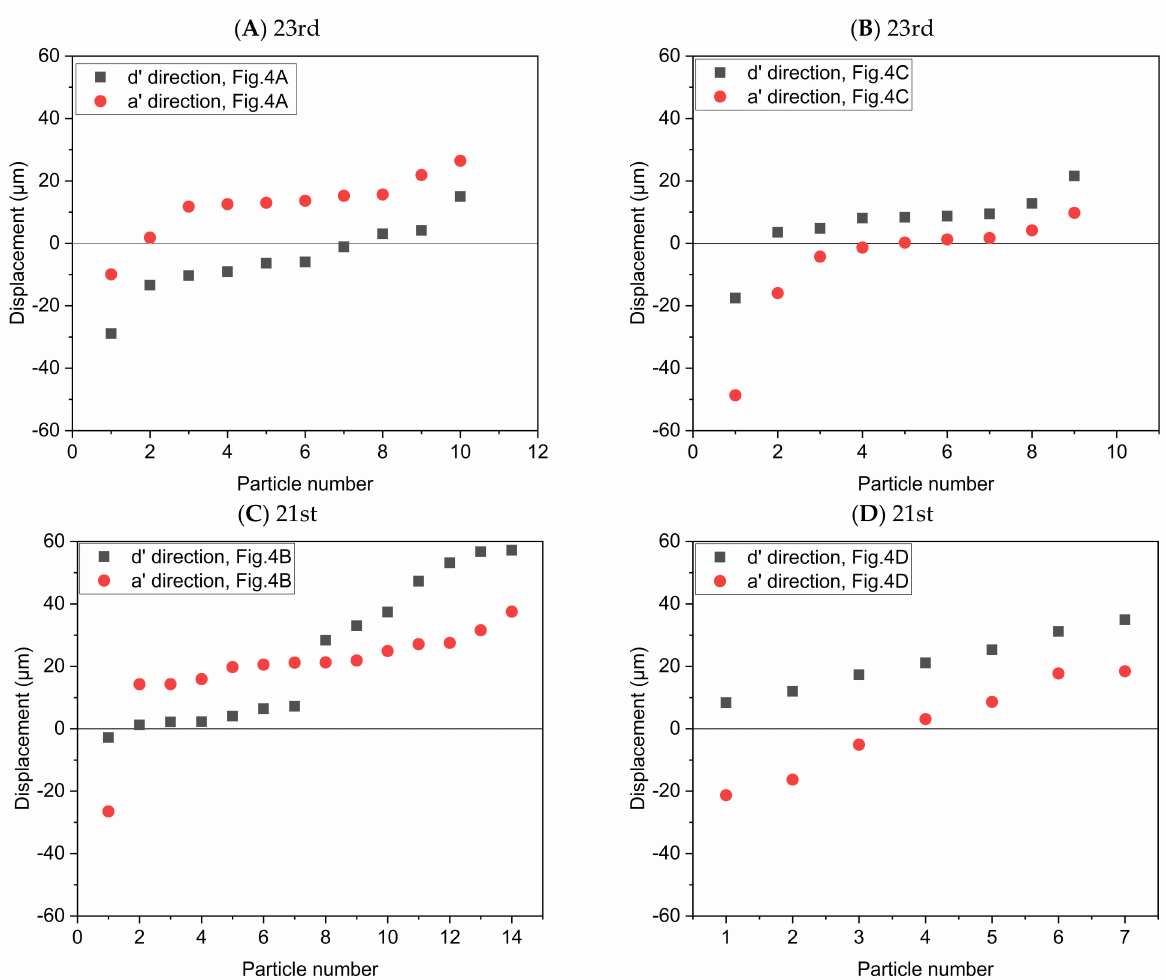
Figure 6. Displacement of the particles after 5 periods in the direction parallel or perpendicular to gravity, respectively. The alveolus arrangement is the same with Figure 4, which respectively corresponds to ( A ) the 23rd generation in Figure 4A; ( B ) the 23rd generation in Figure 4C; ( C ) the 21st generation in Figure 4B; ( D ) the 21st generation in Figure